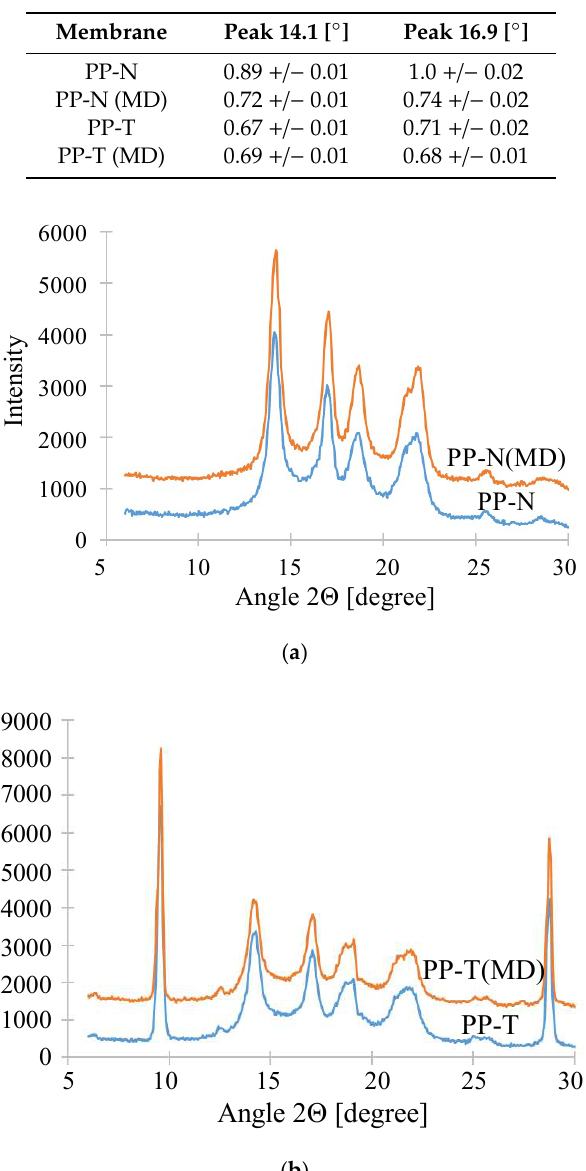
Table 4. The values of full-width at half maximum (FWHM) of the peaks obtained during XRD analysis.